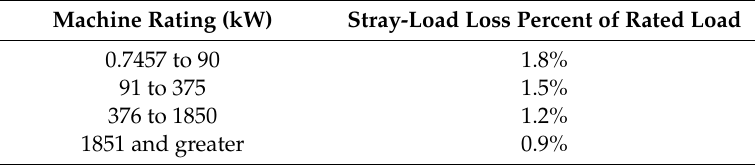
Table 1. Assumed values for stray-load